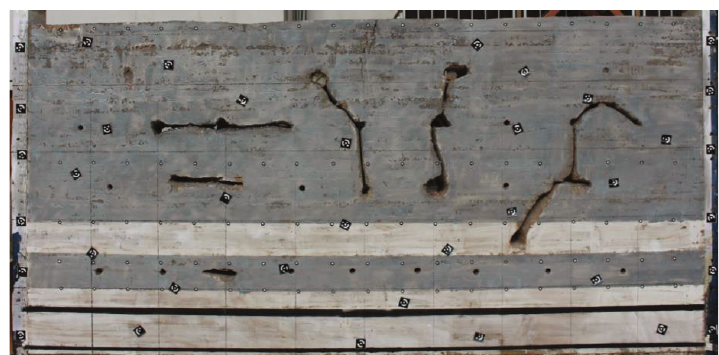
Figure 1: Physical similarity model. Table 1: Physical and mechanical properties of rock